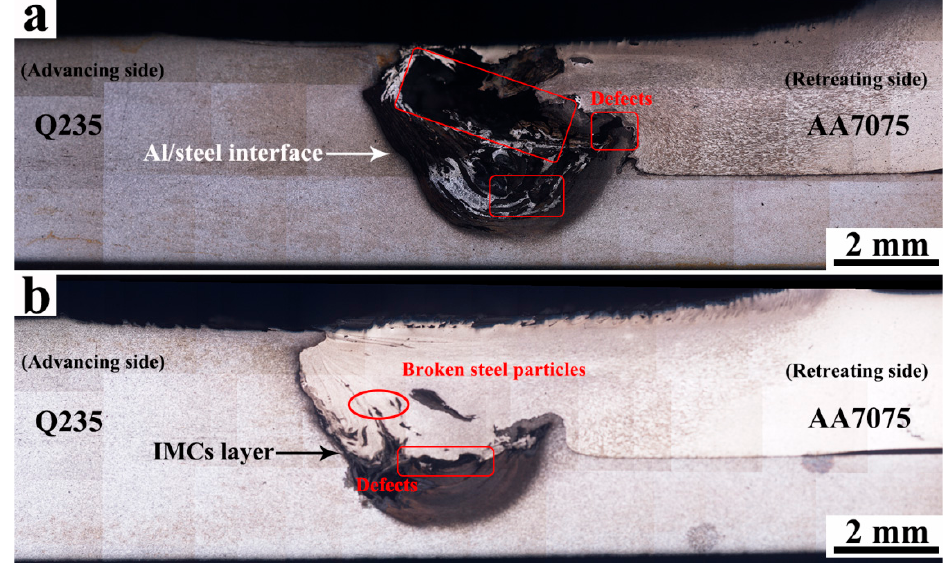
Figure 3. The overviews of dissimilar Al/steel butt-lap joints fabricated via ( a ) FSW and ( b )